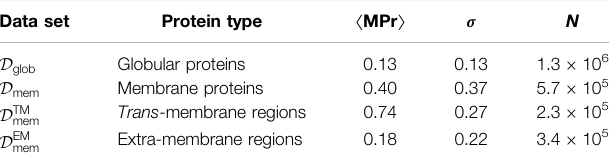
TABLE 1 | Mean per-residue index 〈 MPr 〉 and standard deviation σ of the distributions computed for the four protein structure sets considered in this paper; N is the number of residues in each data set.